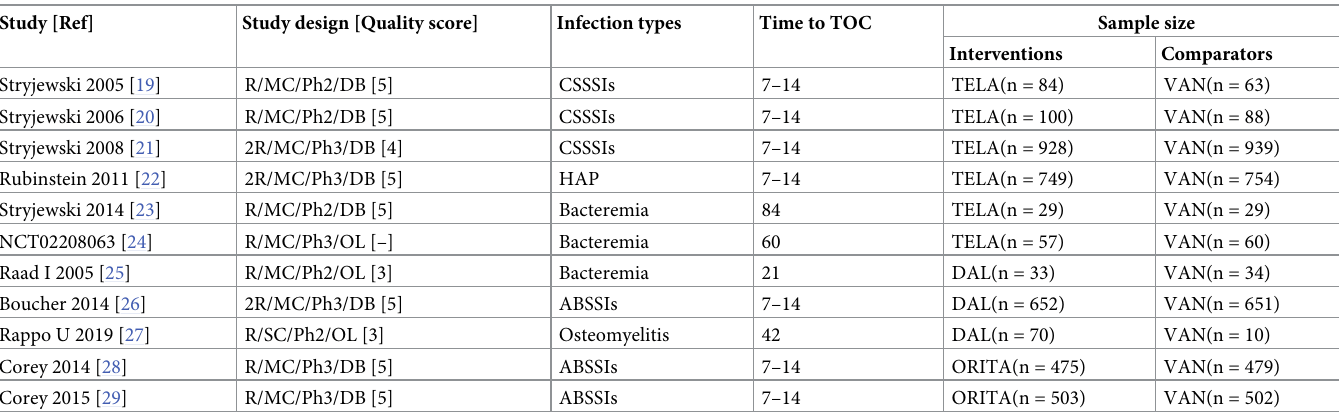
Table 2. Characteristics of included trials in meta-analysis.